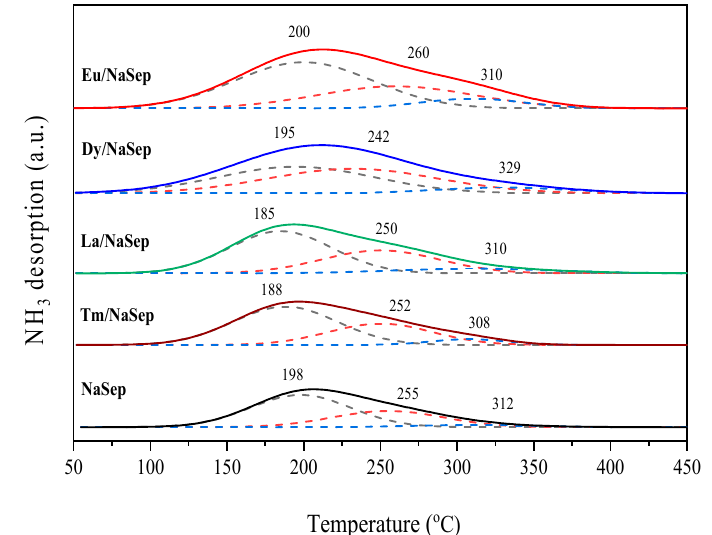
Figure 7. NH 3 –TPD profiles of the samples. Table 3. Ammonia uptakes of the